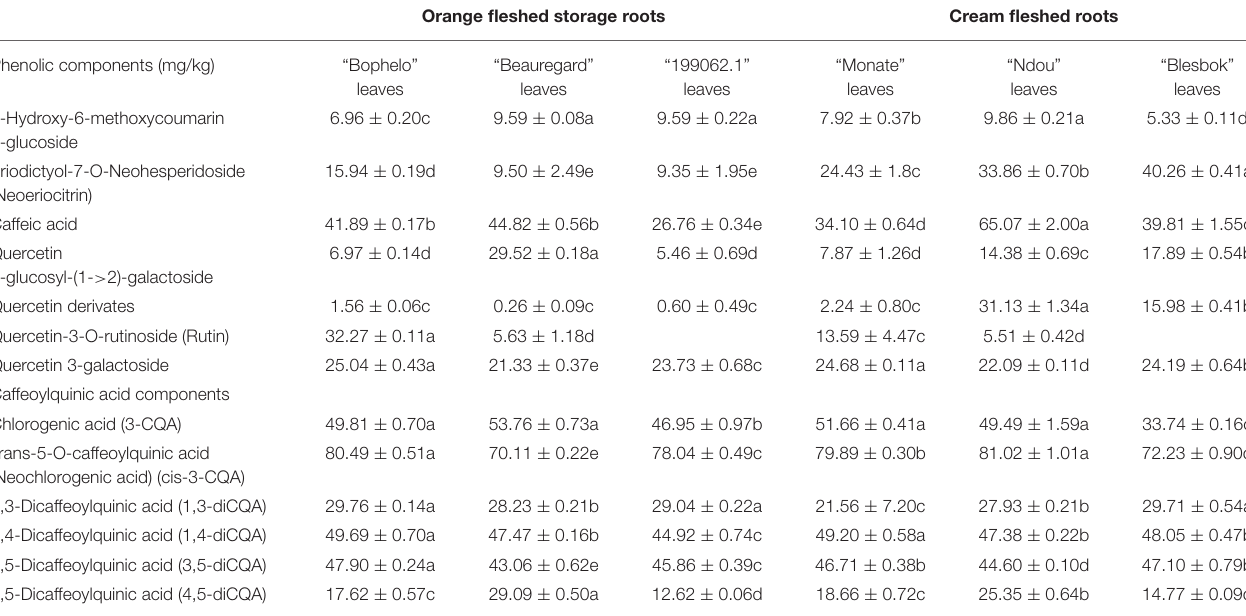
TABLE 2 | Comparison of different phenolic compounds in the leaves of four Southern African sweet potato ( Ipomoea batatas L.) cultivars with “Beauregard” from the USA and Peruvian “199062.1.”